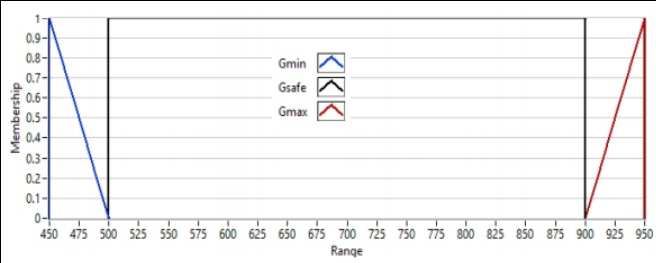
Figure 11: Graph of member functions of Potentiometer